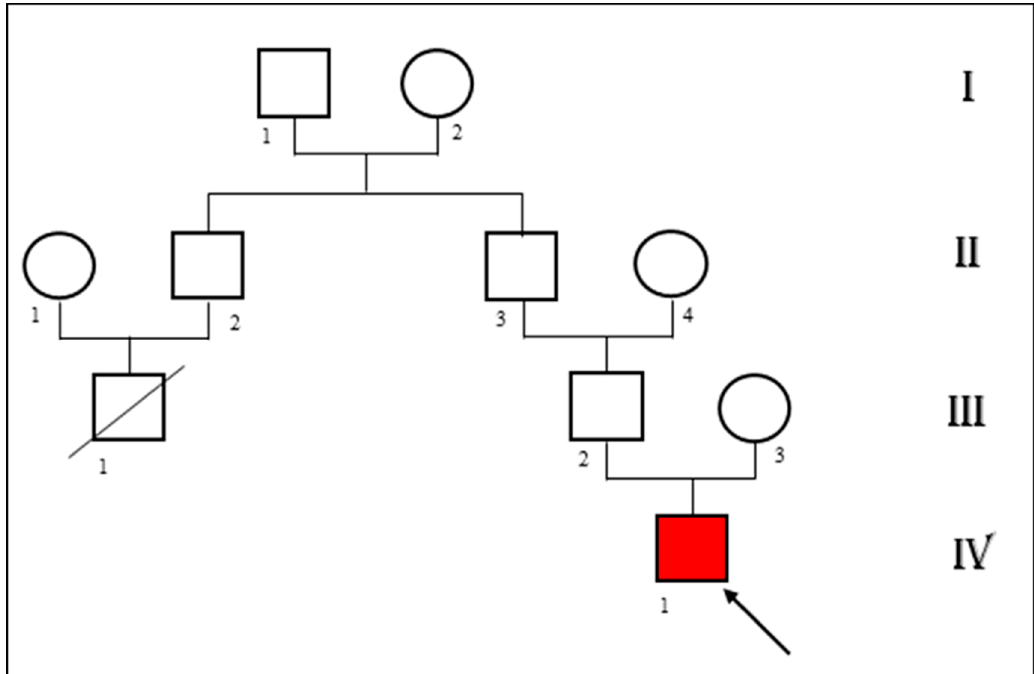
Figure 2. Pedigree showing the patient’s (IV 1) family history. A cousin of the patient’s father died of sudden cardiac death at the age of 35 (III 1).